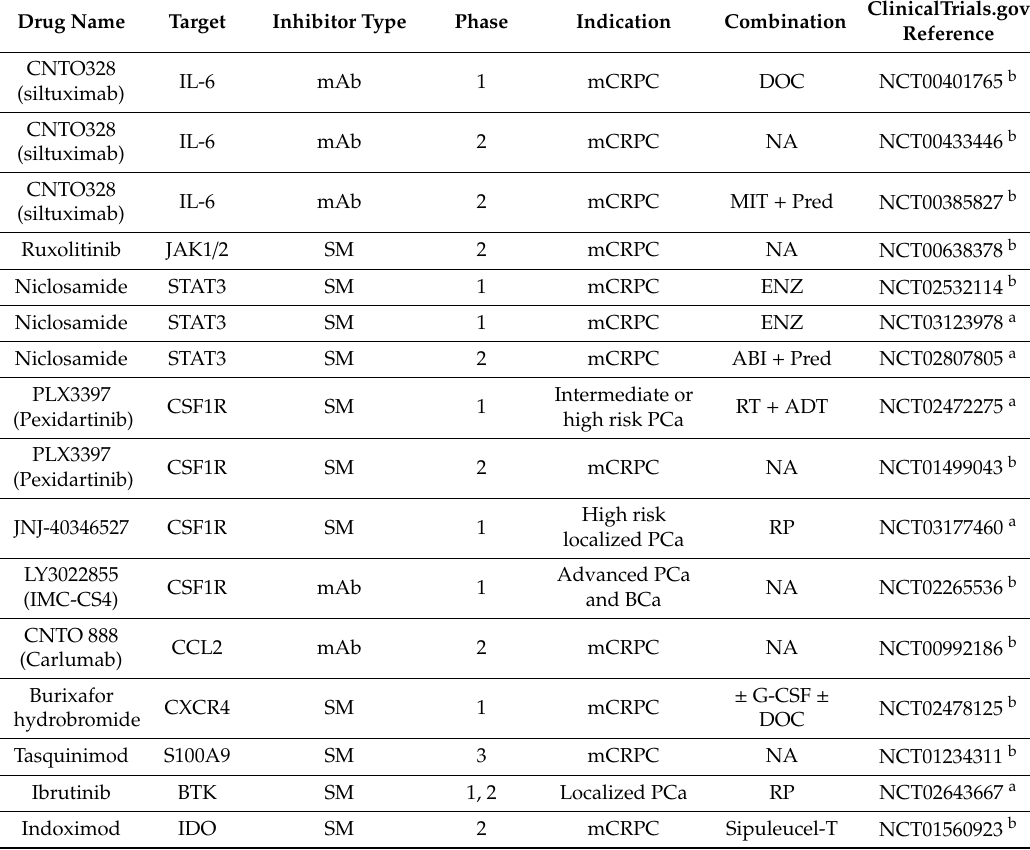
Table 2. Clinical trials of agents targeted at TAMs and / or MDSCs in prostate